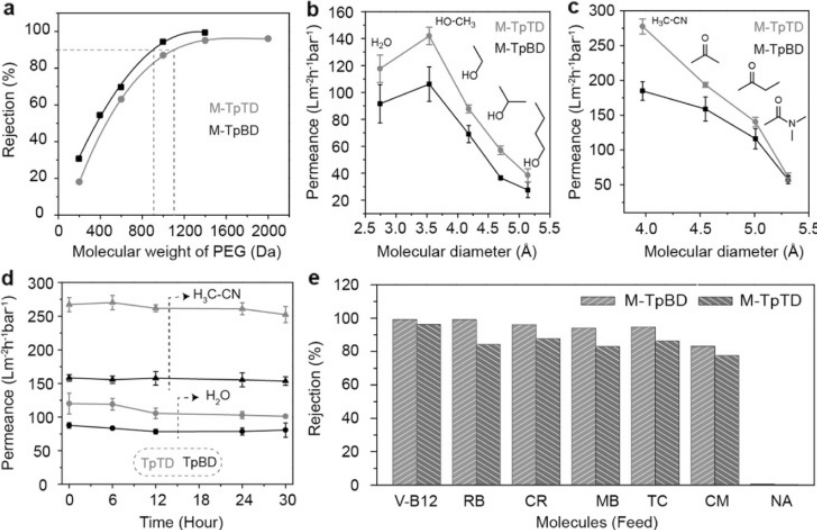
Figure 27. ( a ) Molecular-weight cut-off (MWCO) curve showing that the M-TpBD and M-TpTD had 90% rejection of PEG at 915 Da and 1100 Da, respectively, confirming the pores are in the nanofiltration range; ( b , c ) pure solvent permeance versus molecular diameter of different protic (water, methanol, ethanol, 2-propanol, and n-butanol) and aprotic (acetonitrile, acetone, 2-butanone, and N,N ′ -dimethylacetamide) solvents; ( d ) water and acetonitrile permeance through COMs (M-TpBD and M-TpTD) over time (each 6 h intervals up to 30 h); ( e ) nanofiltration performance of M-TpBD and M-TpTD using different molecules (vitamin B12 (V-B12), rose Bengal (RB), Congo red (CR), curcumin (CM), methylene blue (MB), tetracycline (TC), and nitroaniline (NA)) as a marker in water and acetonitrile (only for CM). A nanofiltration experiment was conducted separately for each aforementioned molecule in a dead-end stirred cell (600 r.p.m.) at ambient conditions and 1 bar upstream pressure. Reprinted with permission from [79], Copyright (2016) John Wiley and Sons publications.